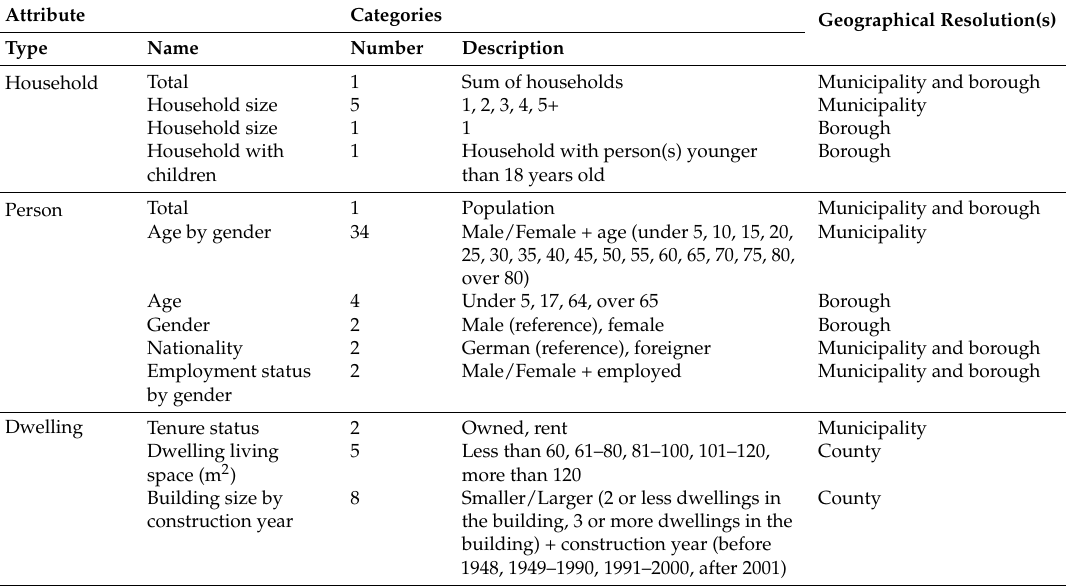
Table 1. Control attributes of the synthetic